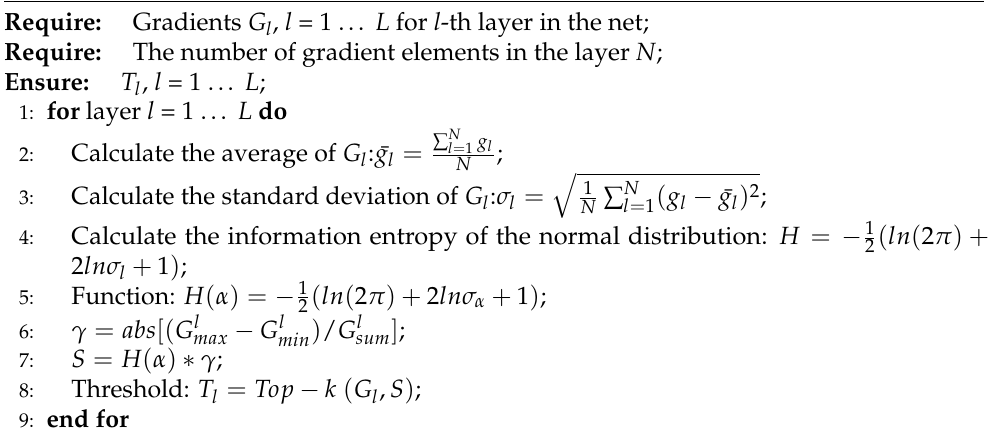
Algorithm 1 Sparse gradient based on information entropy